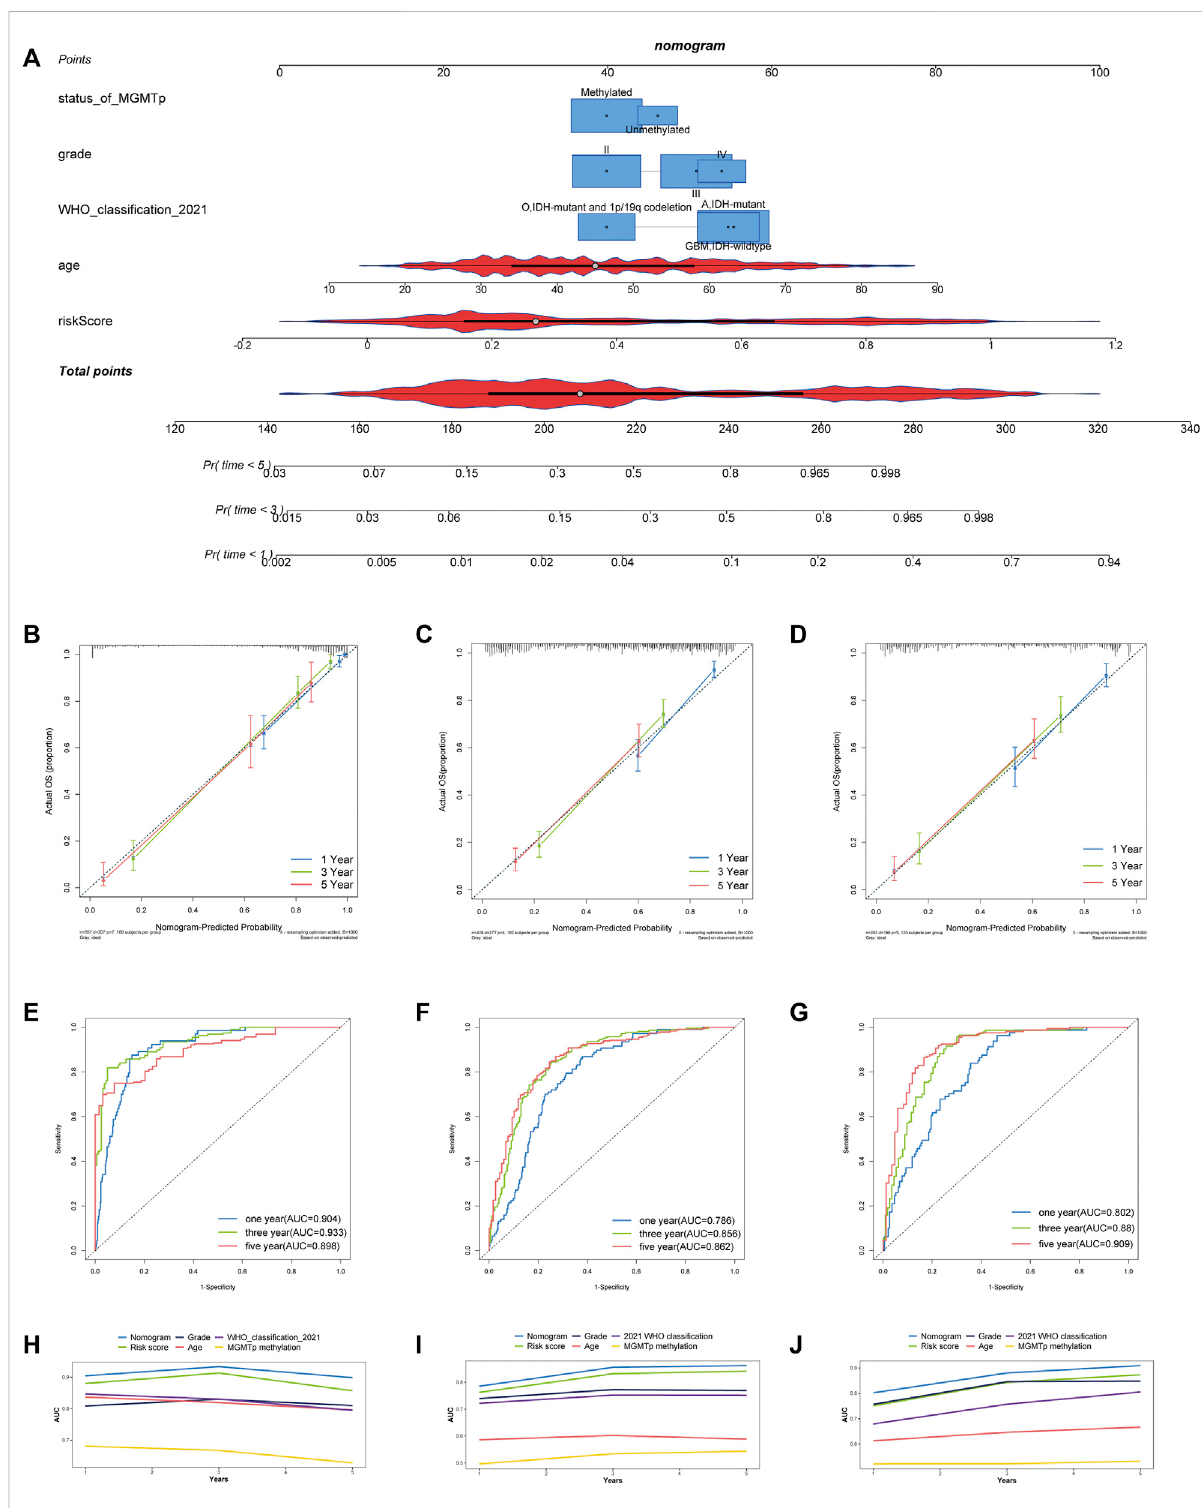
FIGURE 5 Development and assessment of a nomogram in TCGA cohort. (A) Nomogram based on the PRL risk score, age, WHO grade, MGMT promoter status and 2021 WHO classi fi cation. (B – D) Calibration curves that indicate the congruence between predicted and observed 1-, 3-, and 5-year overall survival (OS) in TCGA, CGGA_693 and CGGA_325 cohorts, respectively. (E – G) The receiver operating characteristic (ROC) curve analyses of thenomogram inpredicting1-,3-,and5-yearOSinTCGA,CGGA_693andCGGA_325cohorts. (H – J) LinechartshowingtheAUCvalueofthe nomogram, the risk score, grade, MGMT promoter status, age, and 2021 WHO grade in the TCGA, CGGA_693, and CGGA_325